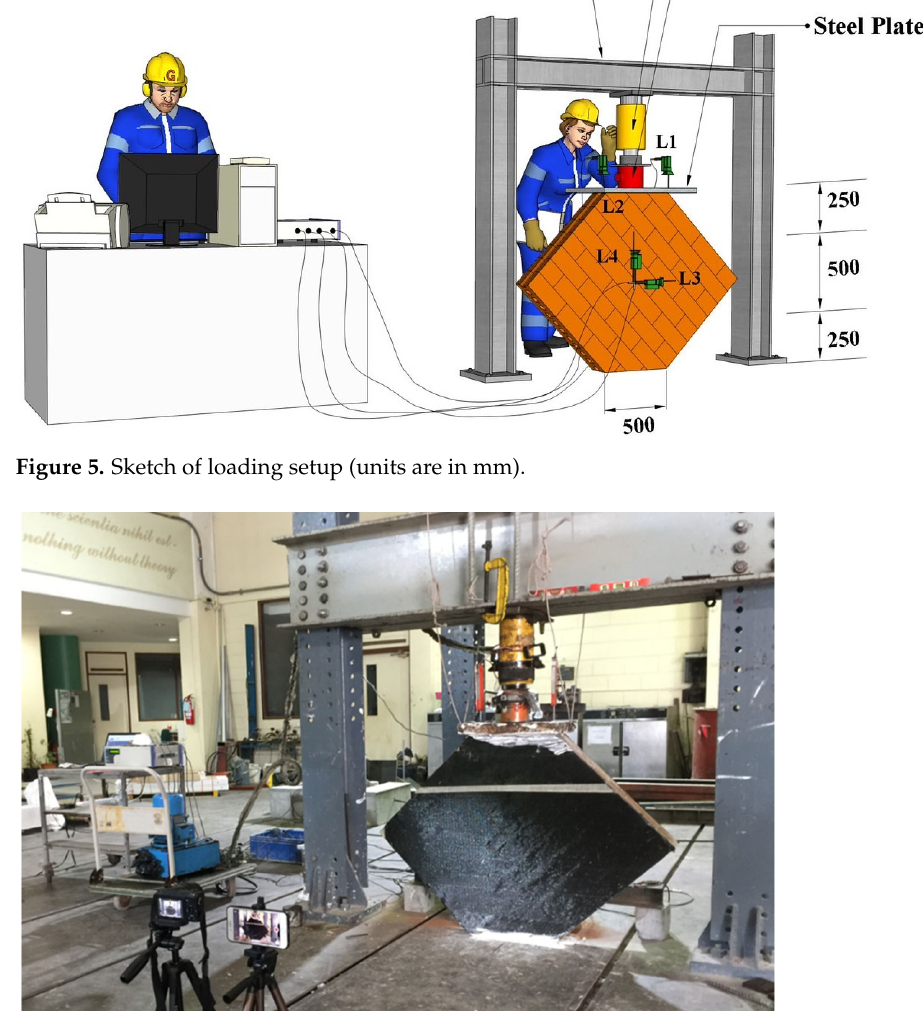
Figure 6. Laboratory view of loading